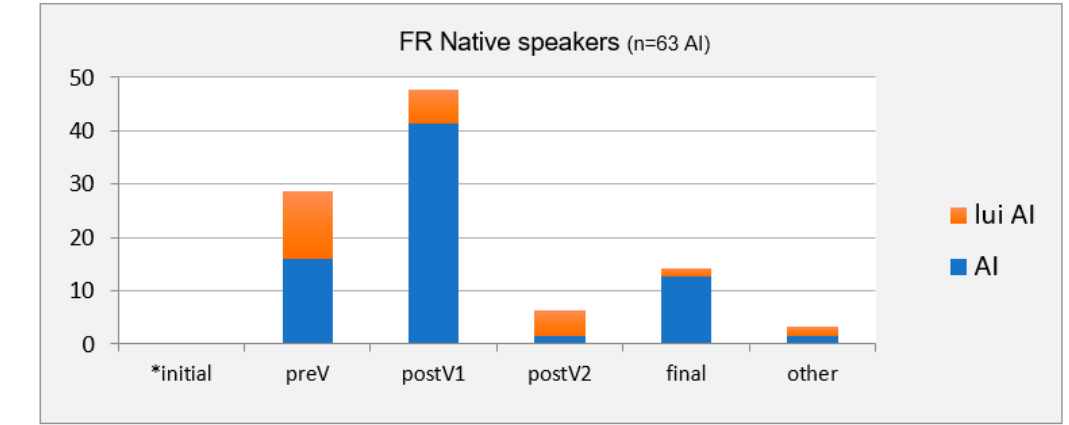
Figure 5. Distribution of additive items “ aussi ”, “ également ” and “ non plus ” in the utterance. AI = additive item; lui AI = additive item with strong pronoun (*= agrammatical position in the TL).